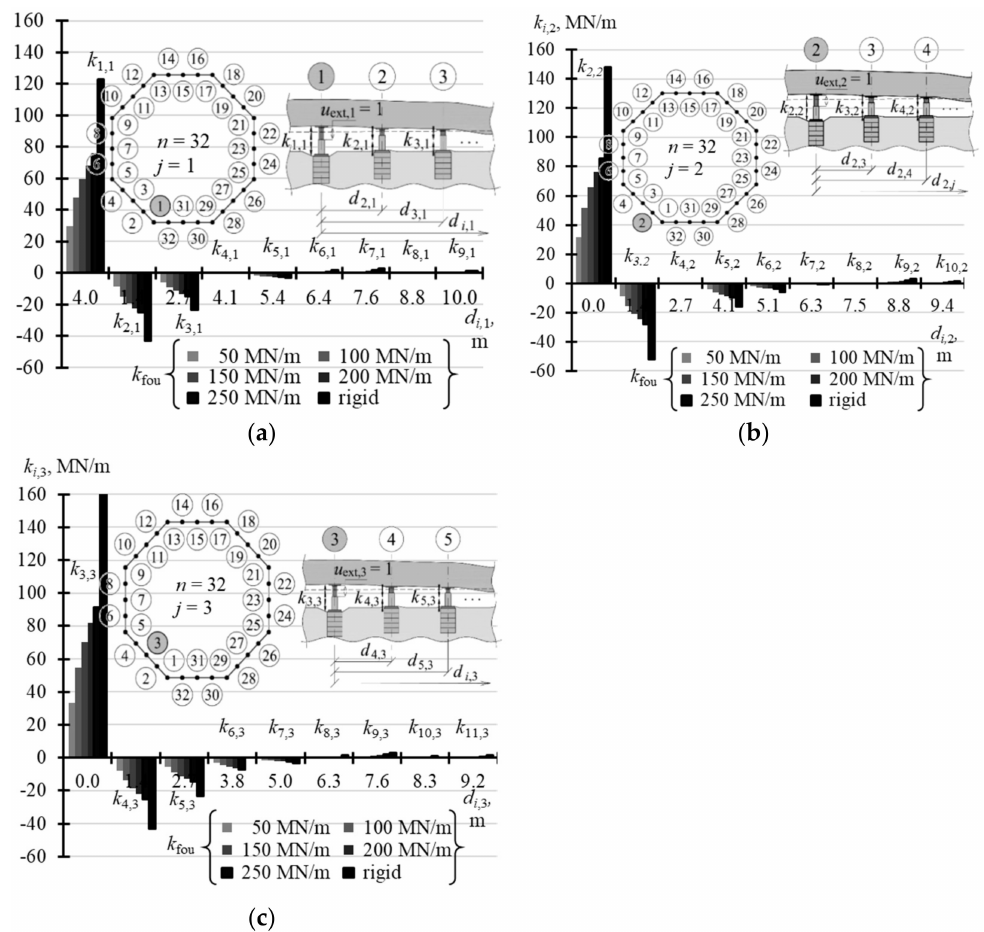
Figure 17. Selected elements of the stiffness matrix k for the structure for different stiffness values k fou of the jack supports when: n = 32: ( a ) element s k i, 1 ; ( b ) element s k i, 2 ; ( c ) elements k i, 3